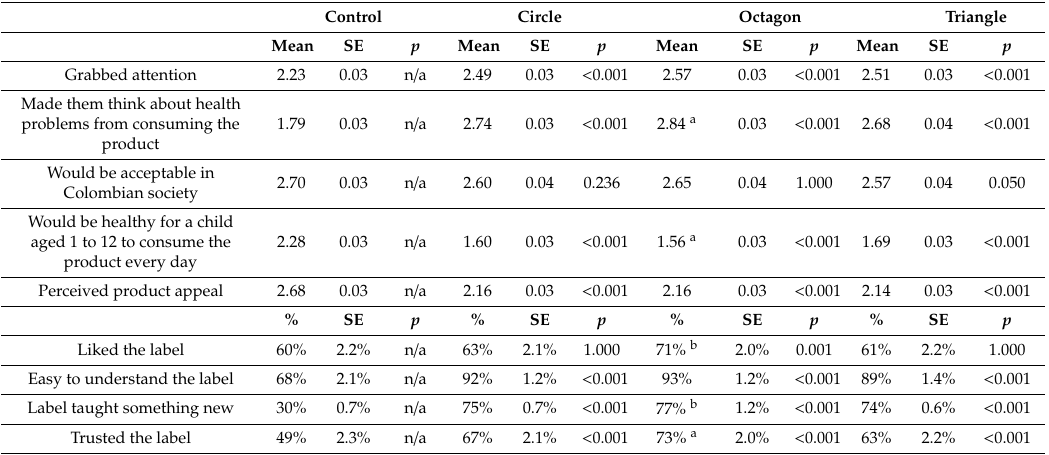
Table 3. Predicted means and percentages of reactions to label types and perceptions of products. Control Circle Octagon Triangle Mean SE p Mean SE p Mean SE